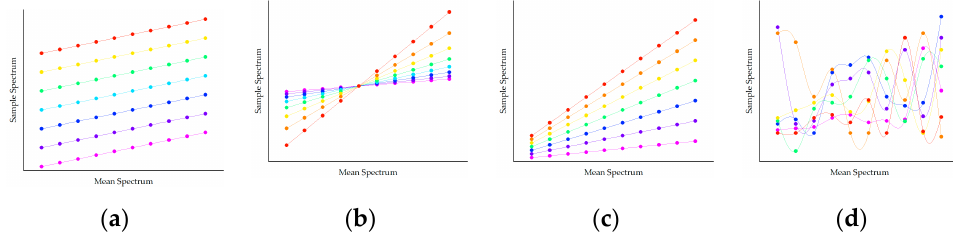
Figure 2. Exemplary scatter effects plots: ( a ) shows additive effects, ( b ) scatter effects, ( c ) a combination of additive and scatter effects and ( d ) shows complex effects [6]. The different colors represent the scatter effect of different spectral data.